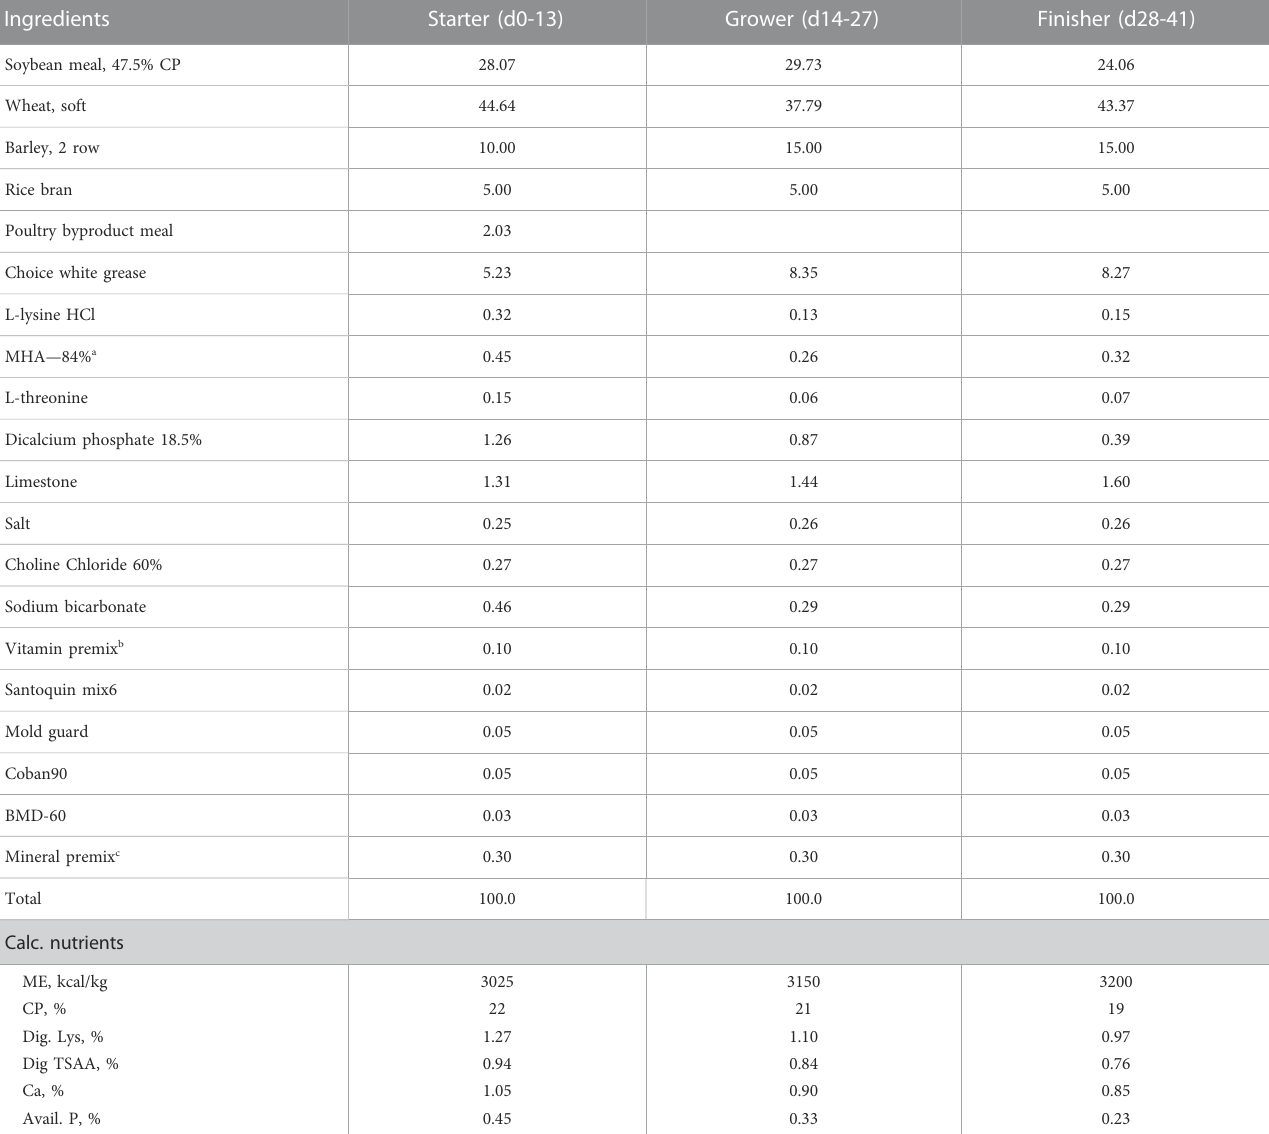
TABLE 1 Composition (%) and calculated nutrient content of basal diets during starter, grower and fi nisher phases in experiment #1.